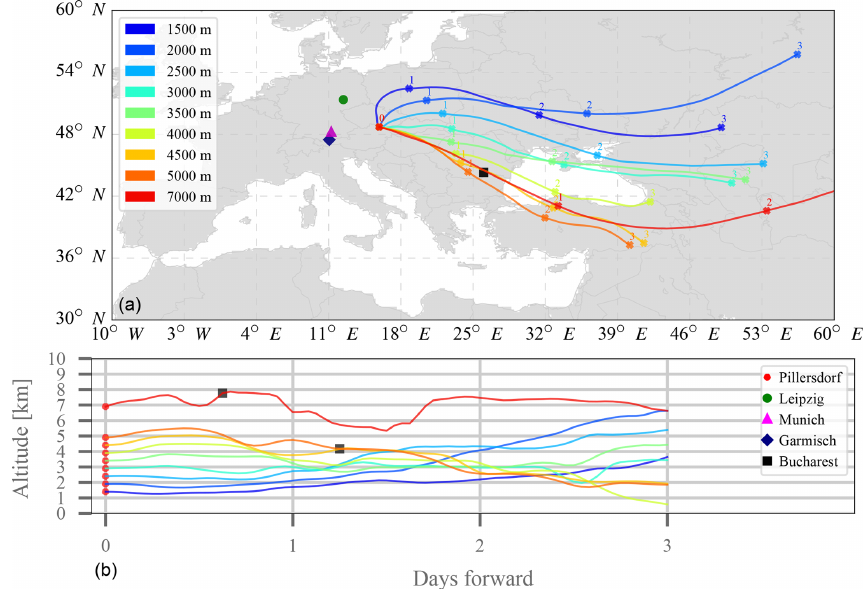
Figure 6. Pattern of forward trajectories (a) and their altitude profile, including overpassed lidar stations (b) for Pillersdorf, 2 April 2014, 06:00.